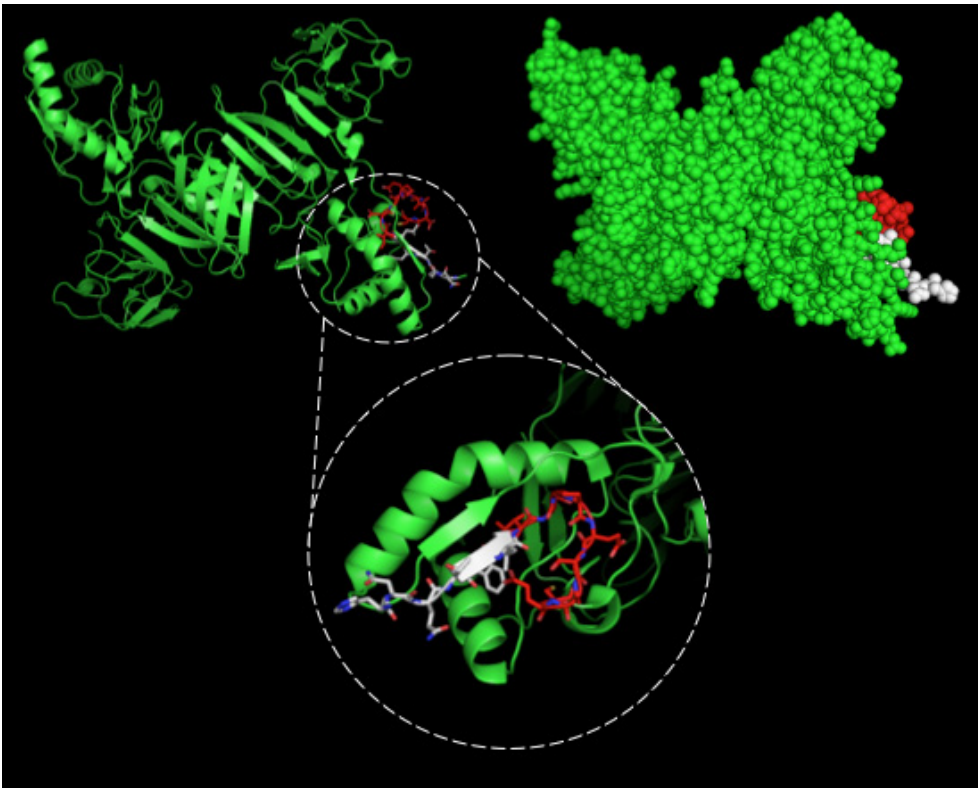
Figure 4. Three ‐ dimensional structural model of a NS1 dimer and regions corresponding to epitopes recognized by 4H2 mAb. The NS1 3D model was generated by the program PyMOL in green. The sequence 127 ELHNQTFLIDGPETAEC 143 is highlighted in red and white. In the detail the red structure represents the novel nine ‐ amino acid sequence described herein.